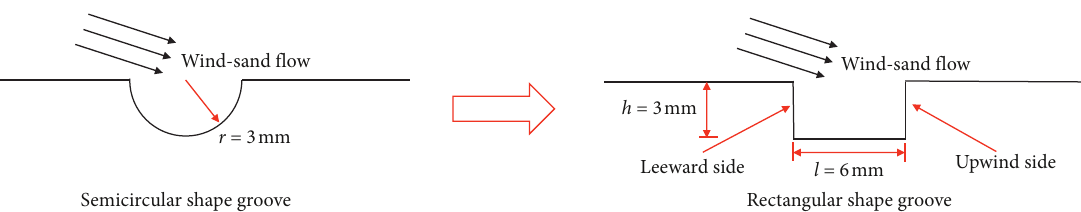
Figure 8: Schematic diagram of the groove changes from the semicircular shape to the rectangular shape. (r), (h), and (l) represent the radius of the semicircular shape groove, the height of the rectangular shape groove, and the length of the bottom side of the rectangular shape groove,